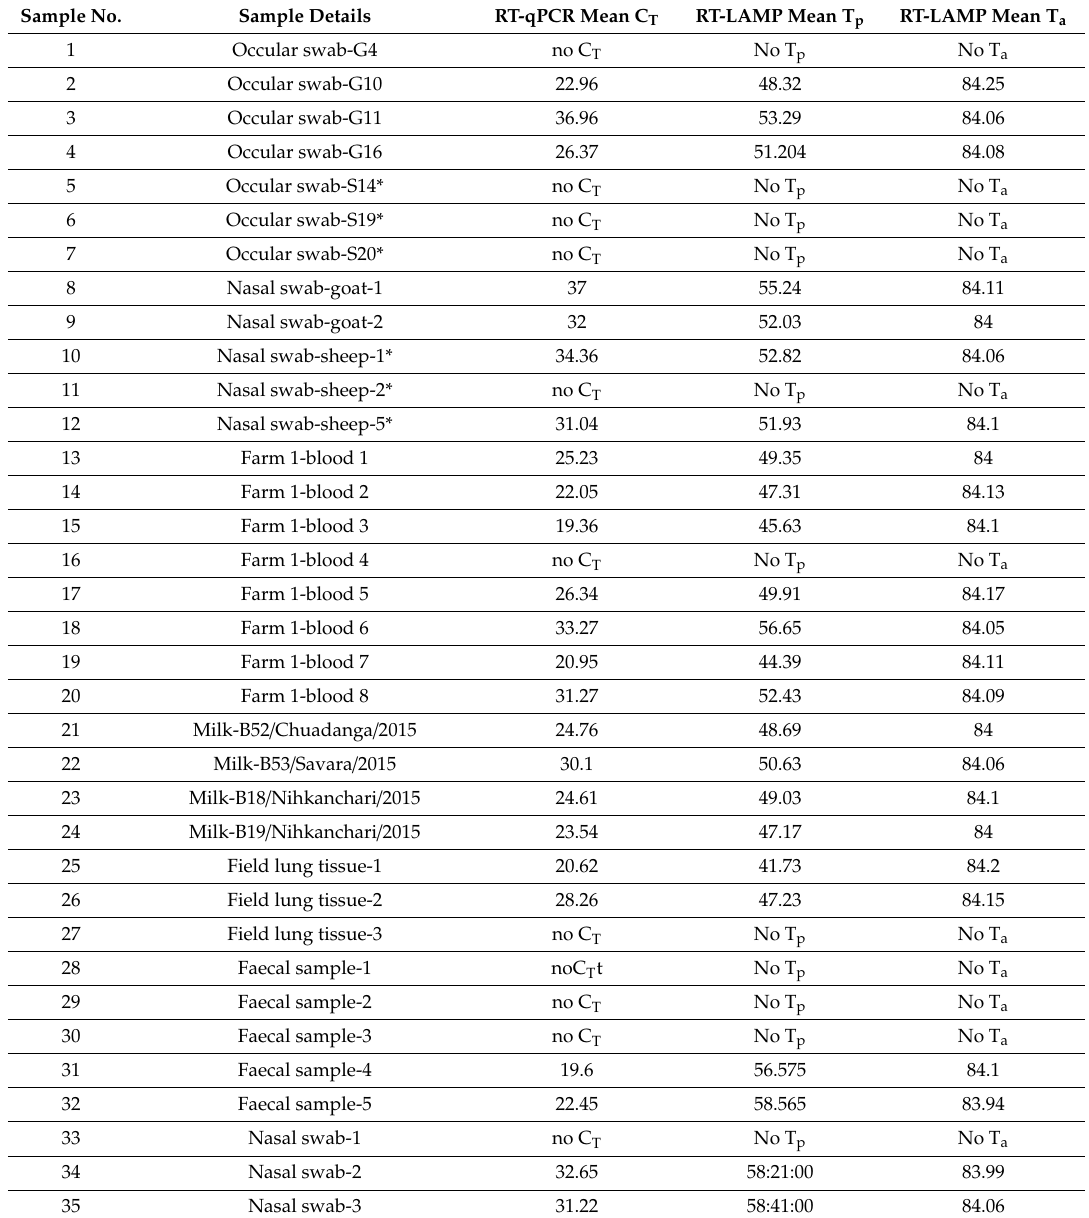
Table 1. Virus isolates and clinical samples used for the development and evaluation of the PPRV RT-LAMP assay. Samples 1–27 were collected from the field whereas samples 28–51 were collected from the animals experimentally infected with PPRV (Morocco / 2008) at The Pirbright Institute (TPI). Samples 1–12 were collected from Tanzania, 13–20 from Algeria, 21–24 from Bangladesh and 25–27 from Israel. The filter paper samples (52–54) were prepared in the lab. Samples with an asterisk are of sheep origin. C T : Cycle threshold values, T P : Time to positivity, T a : Anneal temperature. The lineages of the PPR viruses in sample numbers 55–62 are shown in parenthesis under sample